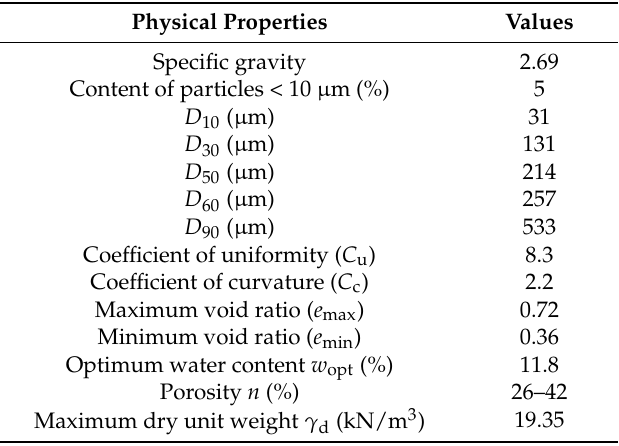
Table 1. Physical characteristics of the sand-tailings mixture used to produce CHF.